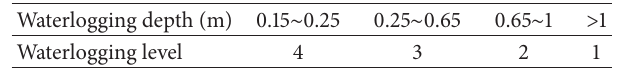
Table 7: The relationship between waterlogging depth and water- logging risk level considering impact of water on traffic, vehicles, production, and residential